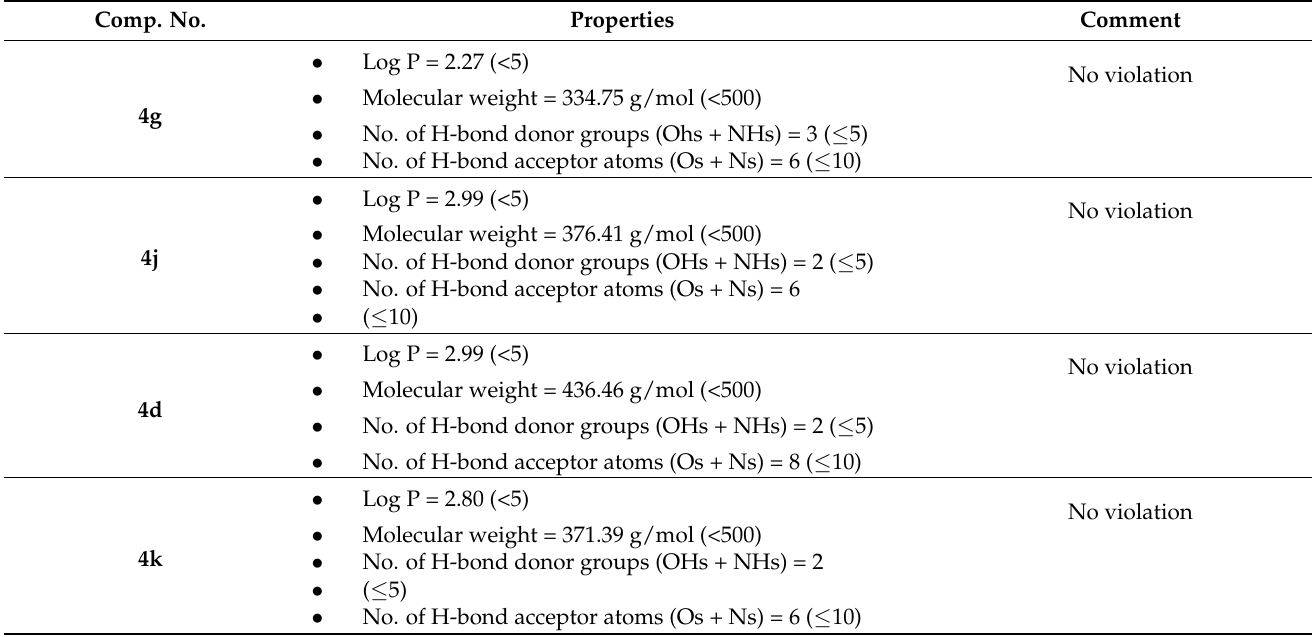
Table 6. Drug-likeness of the tested